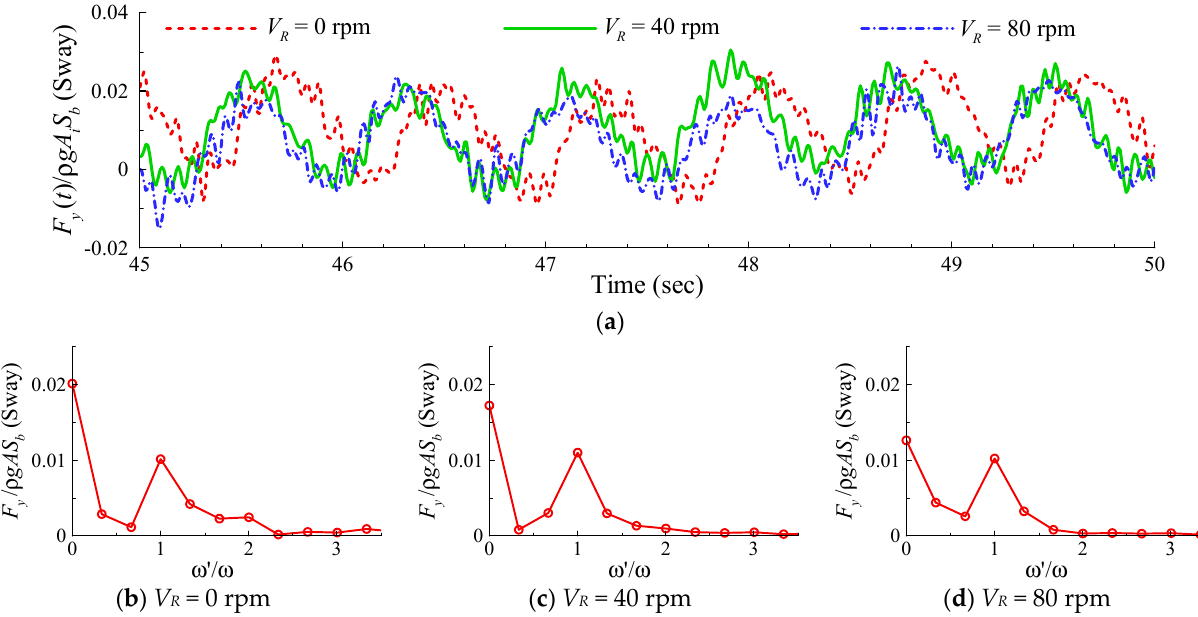
Figure 6. ( a ) Non-dimensional time histories of the mooring force in the y -axis direction at different rotating speeds of the wind turbine ( T = 0.79 sec, M b = 154 g and A i = 0.01 m); ( b ), ( c ) and ( d ) the corresponding amplitude spectra.